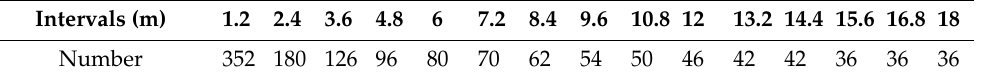
Table 2. The number of sparse RPs with different sampling intervals.